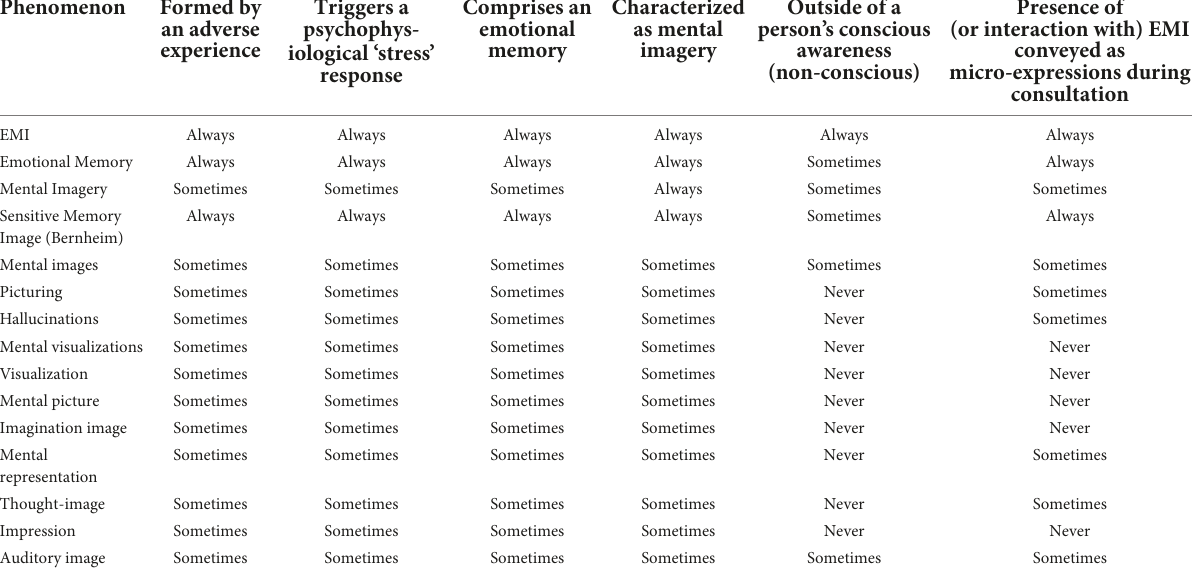
TABLE 2 EMI uniqueness in relation to similar phenomenon: What they are and what they are not.